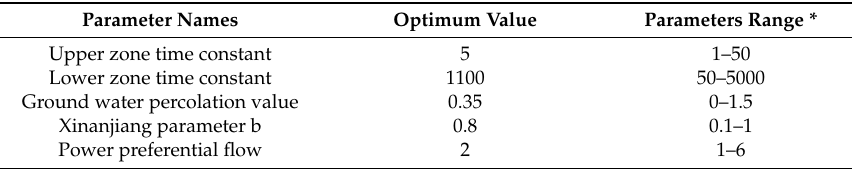
Table 4. Model calibrated parameters.